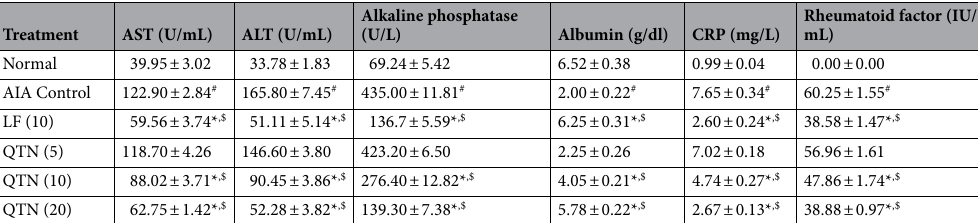
Table 2. Effects of QTN on FCA-induced alterations in serum AST, ALT, ALP, albumin, CRP, and rheumatoid factor levels. Values in parentheses indicate a dose in mg/kg (n = 6). Data were analyzed by one-way ANOVA followed by Tukey’s multiple comparisons test. For comparison with AIA-control group: * p < 0.05, comparison with normal group: # p < 0.05 and comparison with one another: $ p < 0.05. AIA adjuvant-induced arthritis,